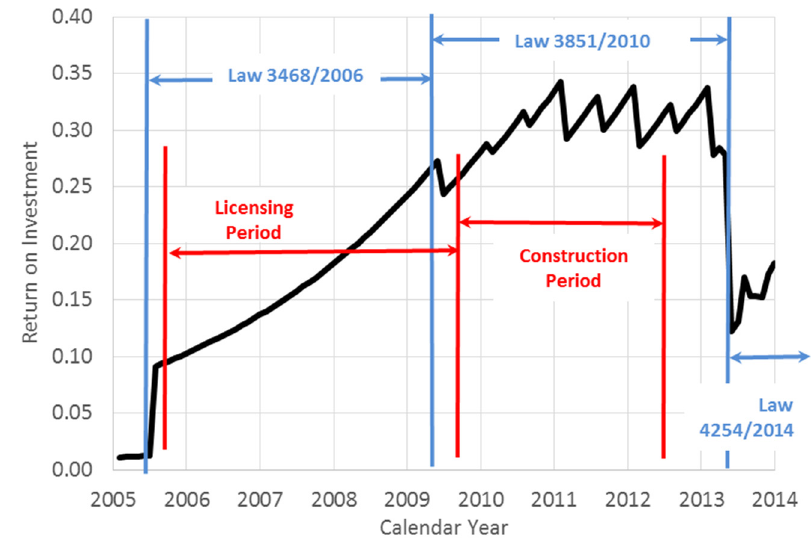
Figure 4. Return on Investment Evolution: An appropriate index to summarize the history of the driving force for PV penetration in Greece.